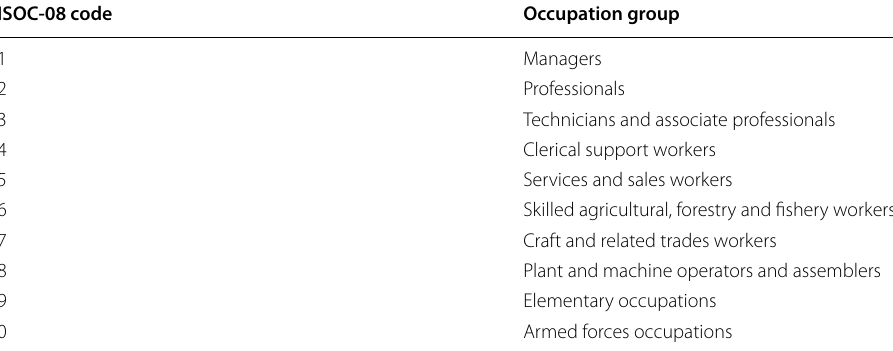
Table 7 Major groups of jobs based on ISCO-08